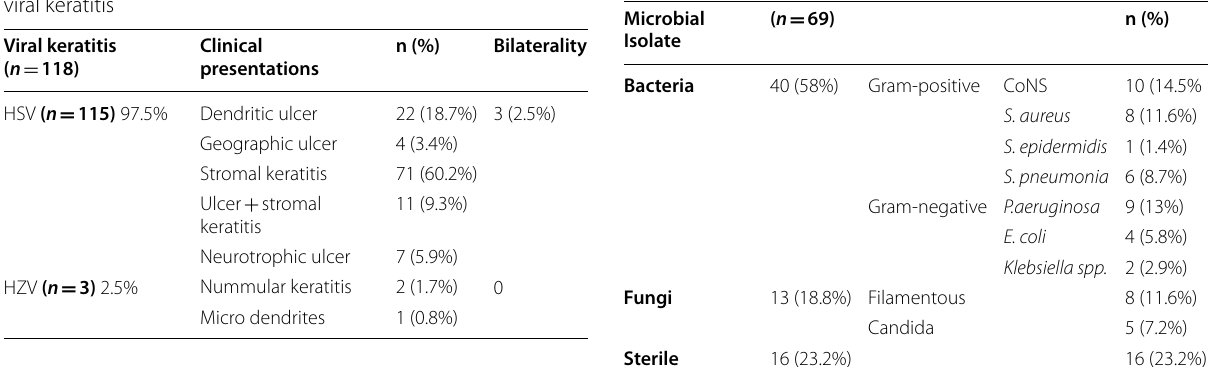
Table 8 The distribution of microbial